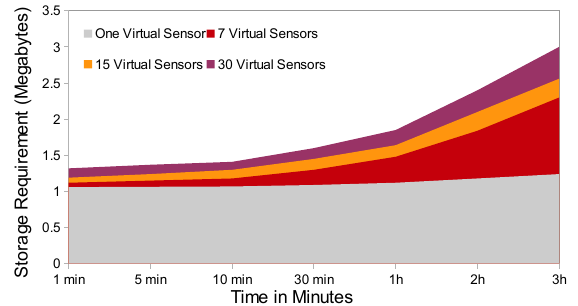
Figure 14. Storage Requirement of MOSDEN client